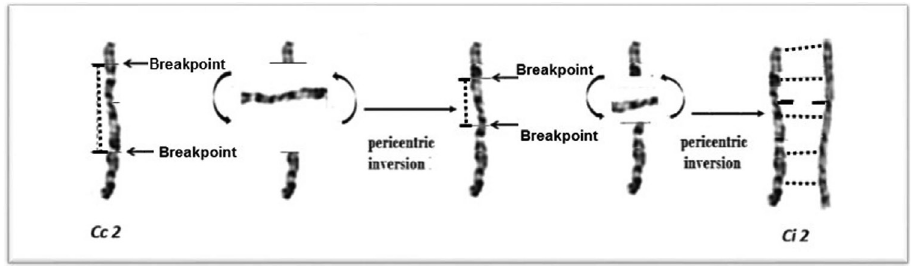
Figure 9. Double inversion that could have occurred during evolution on chromosome 2 between the Common and the Japanese